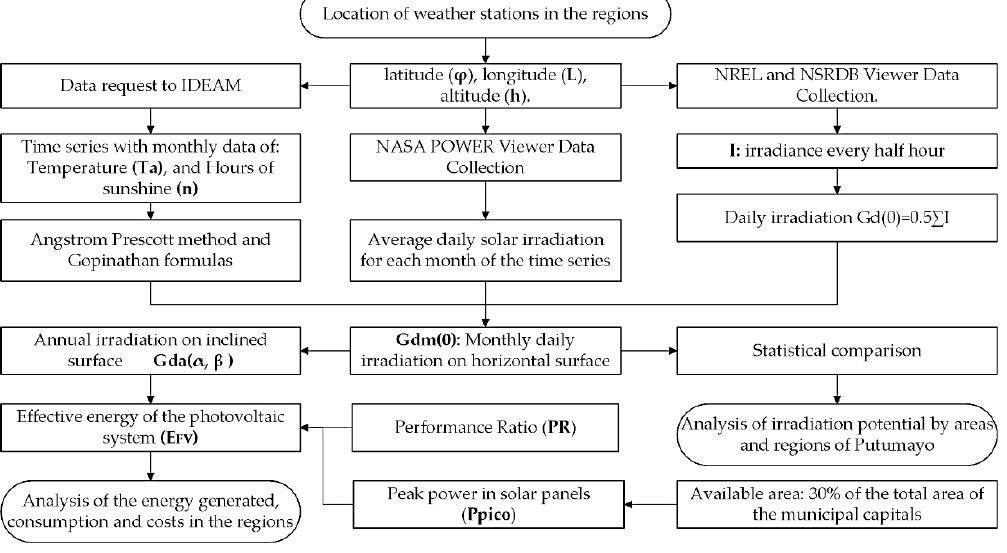
Figure 2. Graphical summary of the methodology used in this research.